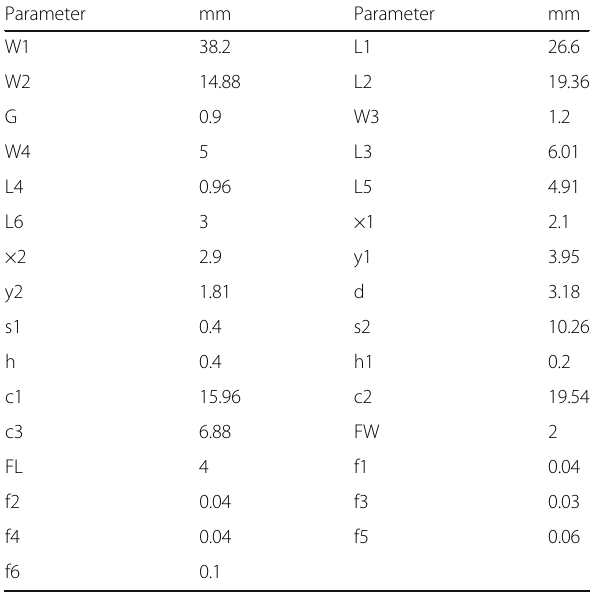
Table 1 Dimensions of the UWB-MIMO